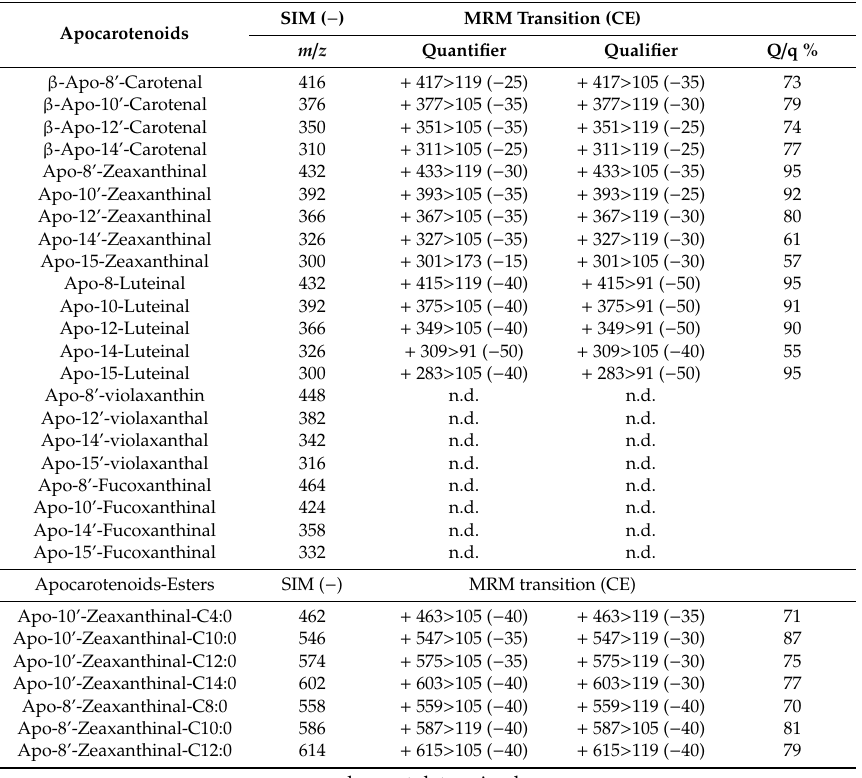
Table 1. Selected ion monitoring (SIM) m / z , Multiple reaction monitoring (MRM) with quantifier (Q) and qualifier (q) transitions (Collision Energy V) and Q / q % ratio of the detected apocarotenoids in the four microalgae strains.